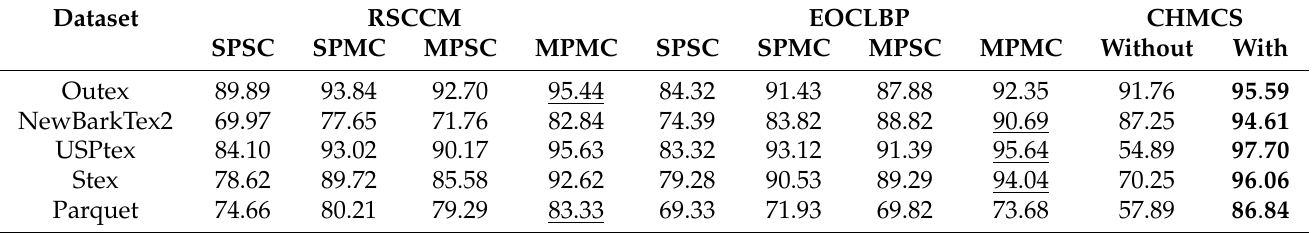
Table 7. Accuracy obtained (in % of well-classified test images) with the CHMCS descriptor compared to other approaches. For each dataset, the highest accuracy is written in bold. The highest accuracy reached by the other approaches is underlined. “With” and “Without” refer to the selection